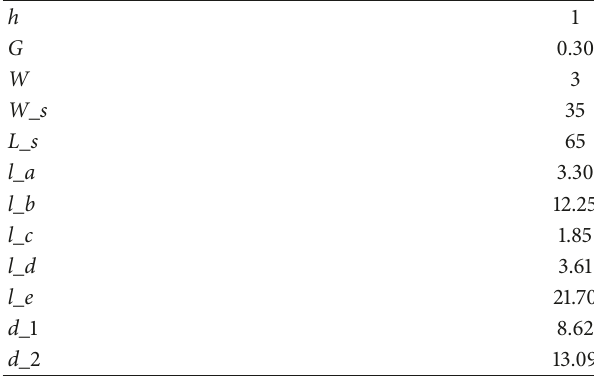
initial linear array, an improved 2 × 2 array with a 6.91% 3 dB